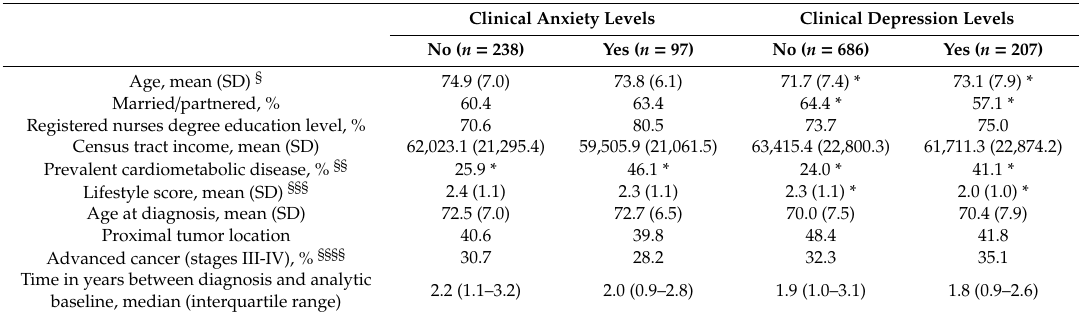
Table 1. Distribution of age-standardized characteristics of NHS women within four years after CRC diagnosis by level of anxiety or depression.